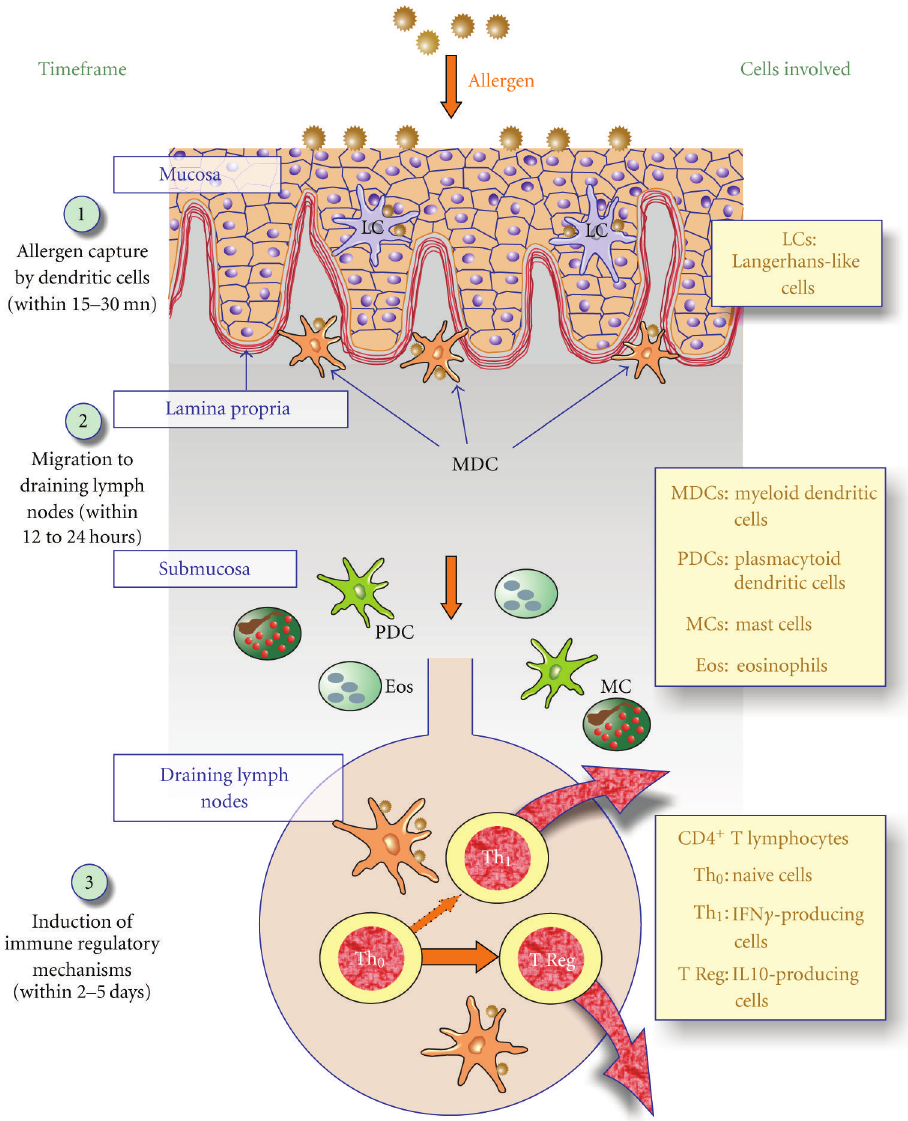
Figure 1: Fate of the allergen following sublingual administration. Following sublingual immunization, substantial amounts of the allergen bind to epithelial cells within minutes, then cross the mucosa between 15 and 30 minutes. The allergen is subsequently captured by dendritic cells (likely by Langerhans cells (LCs) within the mucosa itself and myeloid dendritic cells (MDCs) along the lamina propria) and processed as small peptides presented in association with MHC class I and class II molecules at the cell surface. Those DCs loaded with allergen-derived peptides reach cervical lymph nodes within 12 to 24 hours, where they interact with naive CD4 + T cells to support the di ff erenciation of Th1 and T Reg cells within two to five days. These CD4 + T cells subsequently migrate into the blood and back to mucosal tissues, resulting in allergen tolerance with downregulation of preexisting Th2